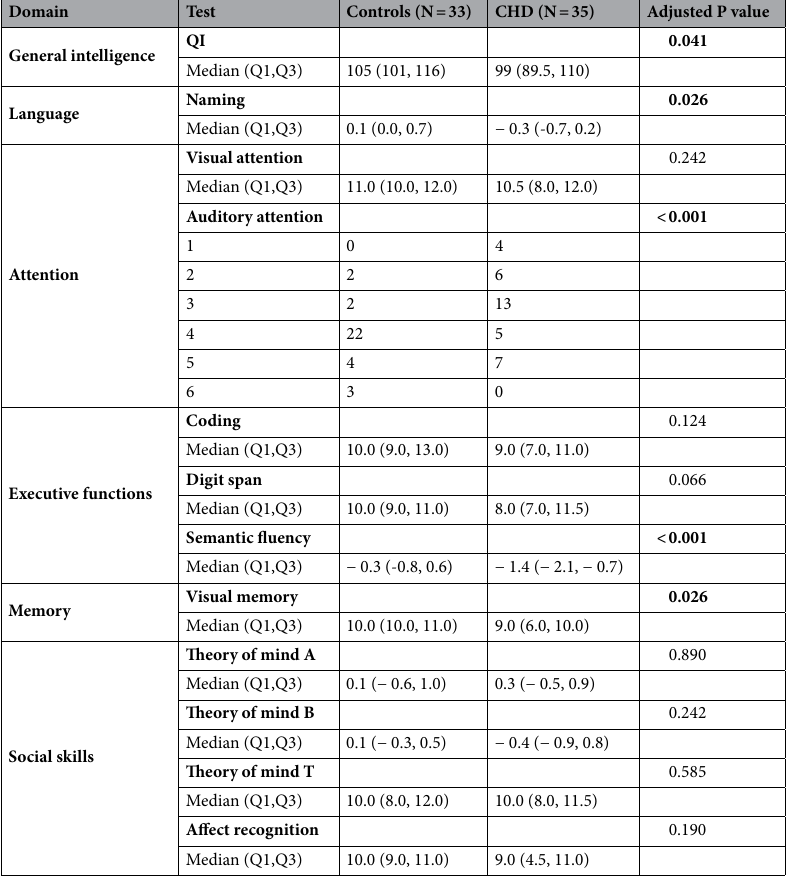
Cluster analysis. Neuropsychology (NPS). Cluster analysis revealed that three clusters explained 55.49% of the point variability of performance at neuropsychological tasks. We evaluated the clusters and determined that the three clusters could be described as follows: The first cluster (Impaired NPS Functioning), accounting for 26% of the sample, exhibited several impairments, particularly in IQ, executive functions, and social skills. The second cluster (Typical NPS Functioning), accounting for 59% of the sample, exhibited average scores in all domains. The third cluster (Good NPS Performance), 15% of the sample, exhibited good performance, par- ticularly in IQ, executive functions, and social skills. The pattern of neuropsychological deficits can be seen in Fig. 2. Numerical data and clinical variable comparisons among clusters are reported in Supplementary Table S2. Symptoms of psychopathology (PSY). Cluster analysis revealed that three clusters explained 59.02% of the point variability of performance on psychopathological questionnaires. We evaluated the clusters and determined that they could be described as follows: The first cluster (Attention Deficit Hyperactivity Disorder—ADHD), 41% of the sample, exhibited increased inattention, hyperactivity, and impulsivity scores. The second cluster (Global Pathological PSY), 12% of the sample, exhibited clinically relevant scores in most domains. The third cluster (Adequate PSY Functioning), 47% of the sample, exhibited adequate scores in all domains. The pattern of psy- chopathological scores can be seen in Fig. 3. The combination of the cluster analyses of neuropsychological and psychopathological scores shows that 31% of patients had no problems and belonged to the clusters designated Typical NPS (23%) or Good NPS Performance (8%) and Adequate PSY Functioning; however, 26% of patients belonged to Typical NPS Func- tioning but had ADHD, and 8% belonged to Global Pathological PSY; 5% belonged to Good NPS Performance but had ADHD. Finally, 14% exhibited Impaired NPS Functioning alone, 8% with additional ADHD, and 2% with additional Global Pathological PSY. Numerical data and clinical variable comparisons among clusters are reported in Supplementary Table S2. Correlation with medical parameters. No significant correlations were found between neuropsycho- logical and psychopathological tasks with clinical parameters in CHD children. No differences in clinical param- eters were found between the clusters (Tables S2 and S3).